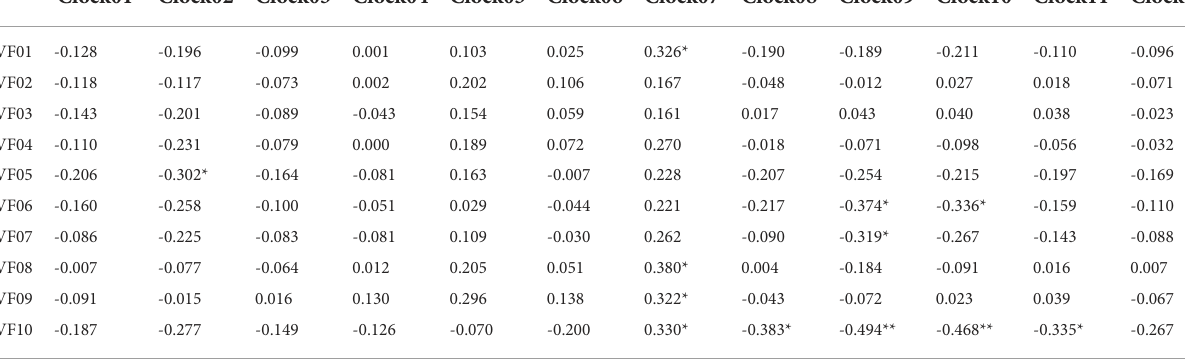
TABLE 3 The correlation coef fi cient of VF and RNFL for the intracranial group.